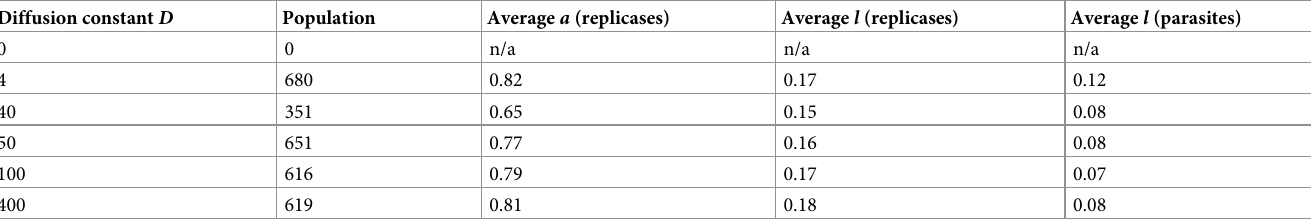
Table 4. System parameters values after 10000 steps of simulation in case of different values of diffusion constant D (Scenario 4). Diffusion constant